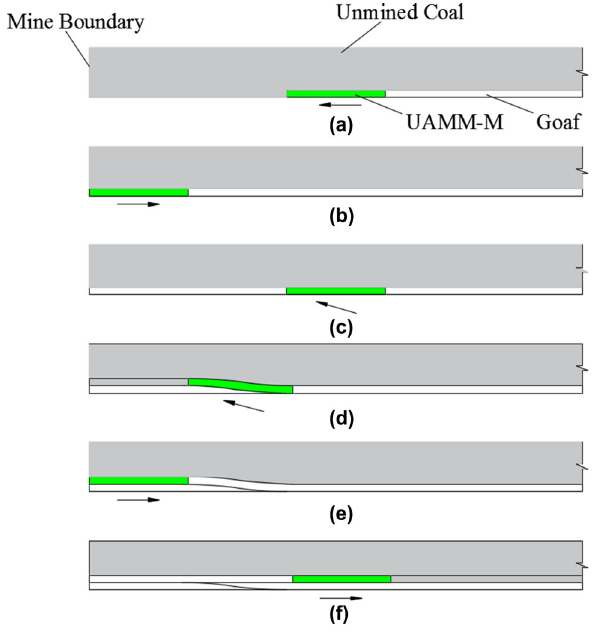
Fig. 5 Lane-switching procedure during two-direction coal mining by the